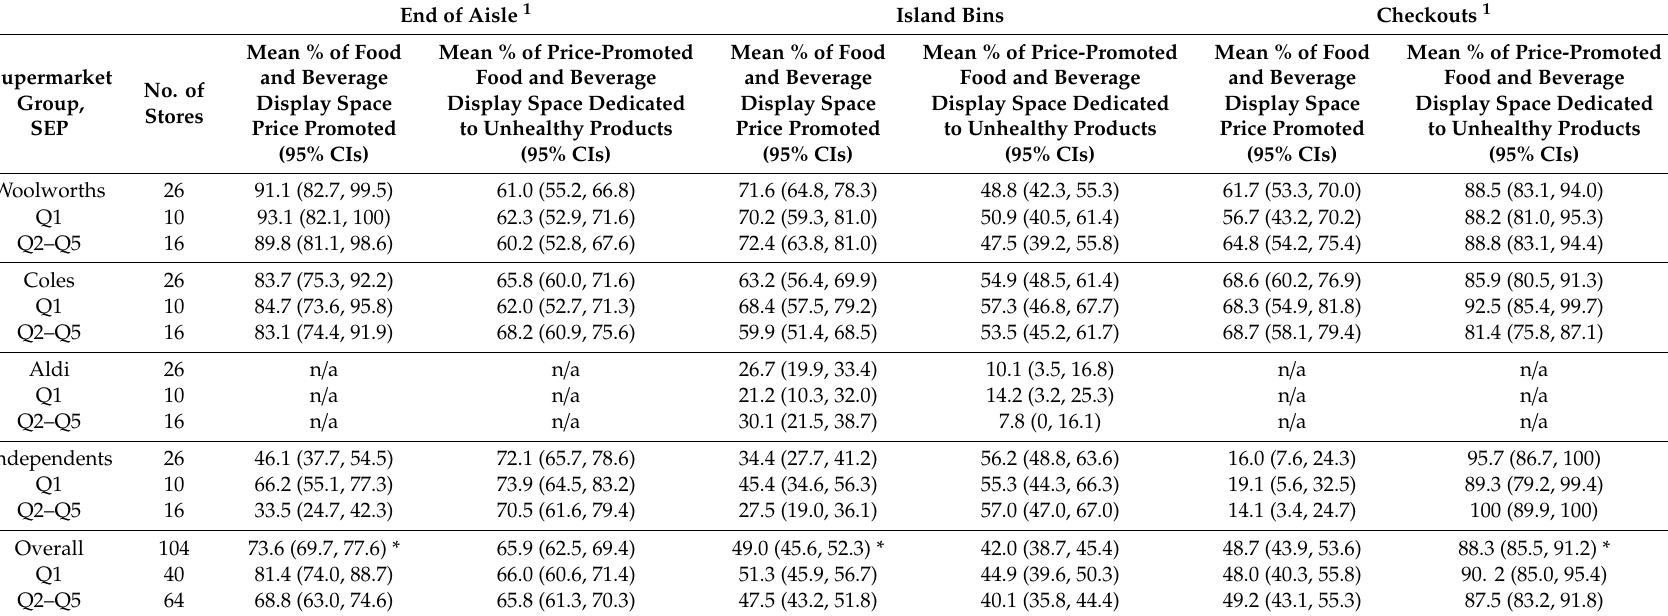
Results of linear models that included supermarket group, SEP and interaction of supermarket group by SEP. * indicates that the interaction of supermarket group by SEP was significant ( p < 0.05); 1 Aldi not included in the linear model for end-of-aisle or checkout displays due to there being insu ffi cient numbers of price promotions in those locations. n / a: not applicable, as Aldi did not have enough observations. Socio-economic position (SEP) based on quintiles of Australian Bureau of Statistics Index of Relative Socio-economic Advantage and Disadvantage. Q1: most disadvantaged. CI: confidence